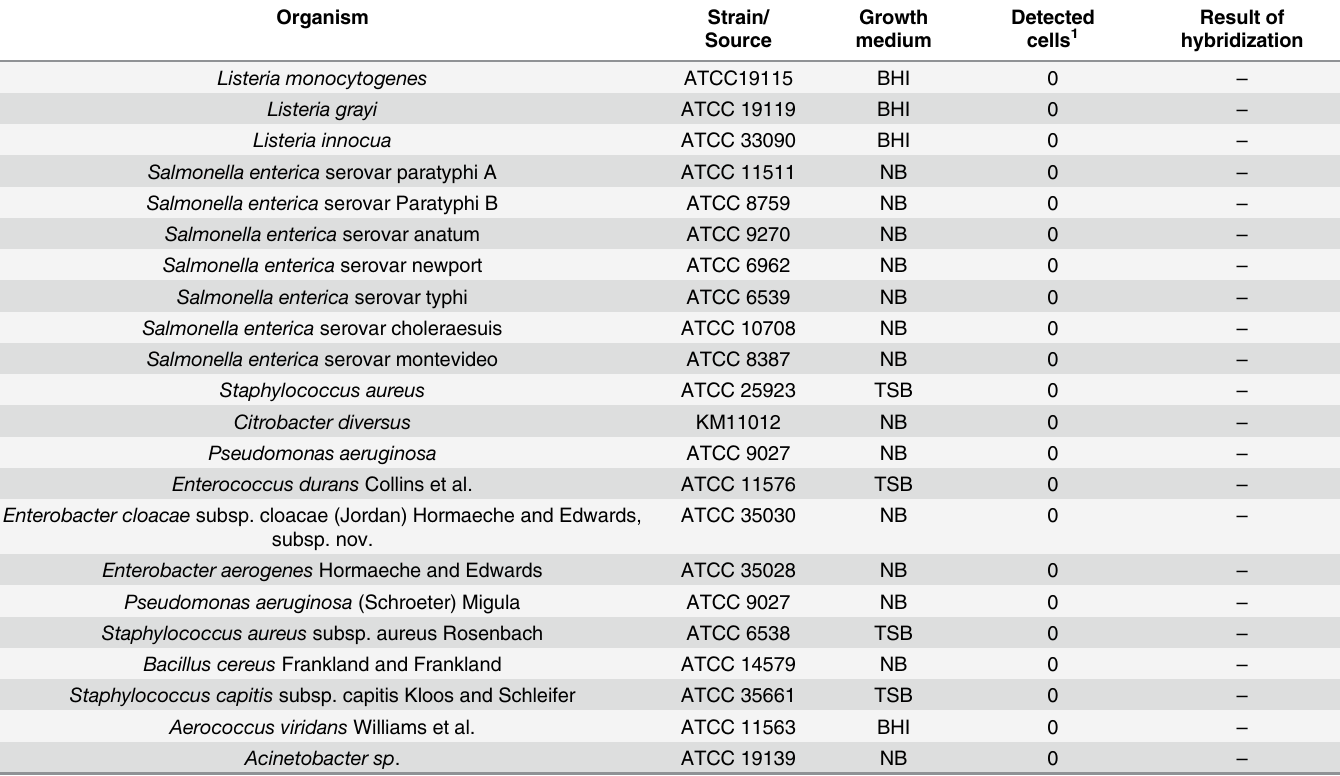
Table 2. Exclusivity panel result. Organism Strain/